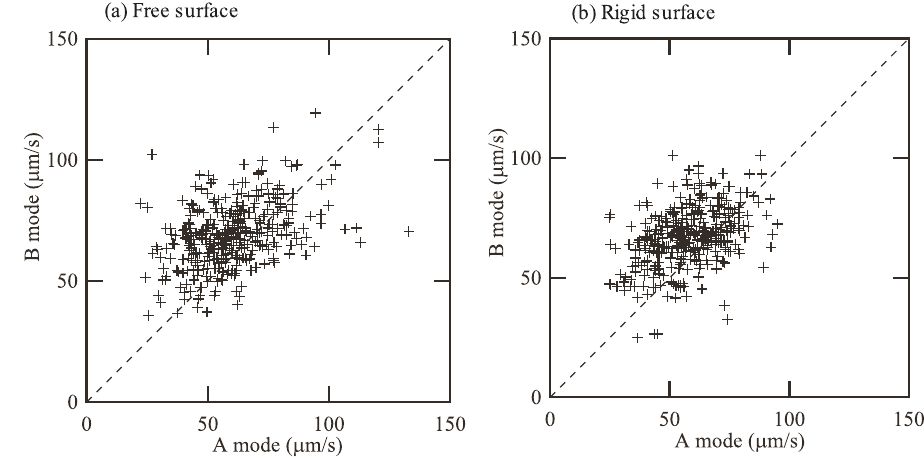
Fig. 4 Correlations of swimming speed of A and B modes in YM4 swimming (a) near the free boundary and (b) near the rigid boundary. The dashed lines are guided to the eye; forward and backward swimming have the same speed. The number of data points is > 300 for both